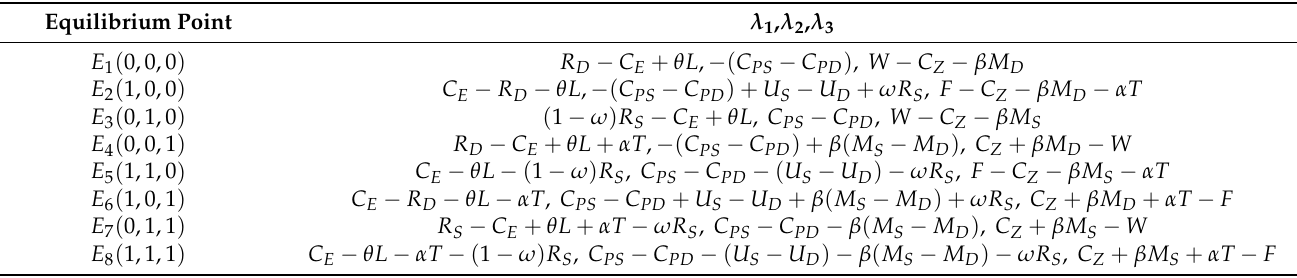
Table 3. The eigenvalues of each equilibrium